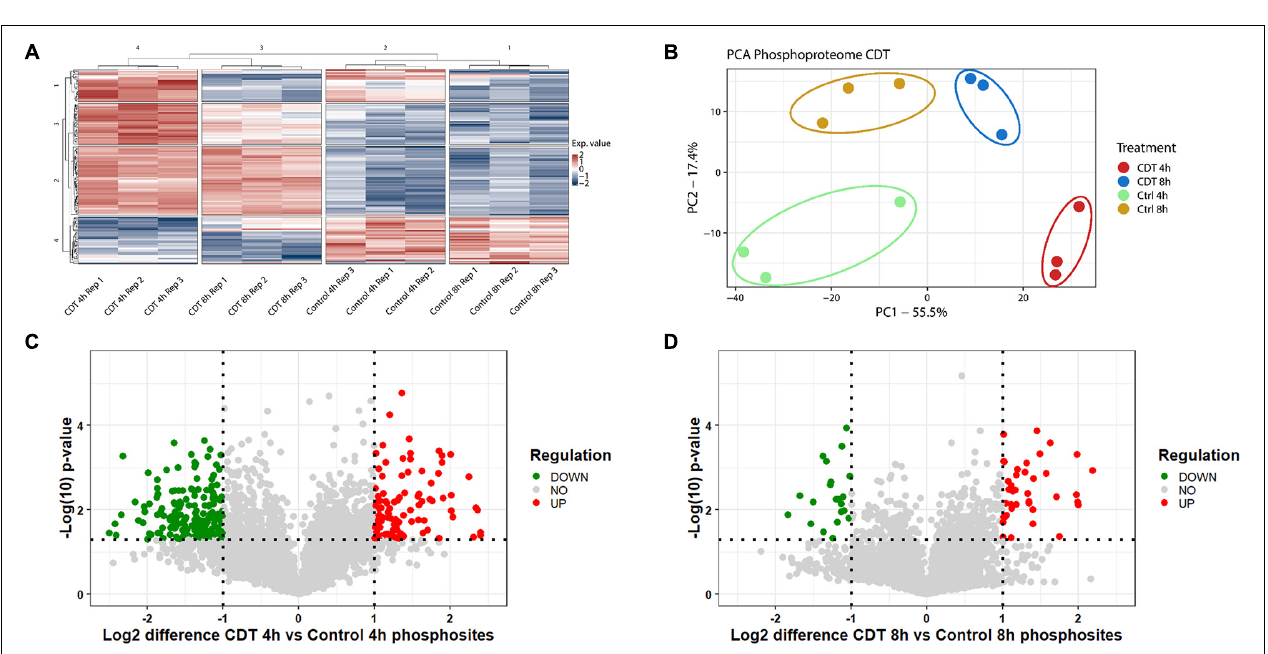
FIGURE 3 | Phosphoproteome analysis of with CDT-treated HEp-2 cells after 4 and 8 h. (A) Heat map of significantly changed phosphosites ( p < 0.05) based on intensity values and Benjamini Hochberg FDR ANOVA testing; Exp. value: expression value; numbers of row and column cluster are for coordinative reasons and have no underlying meaning. (B) Principal component analysis (PCA) of significantly changed phosphosites ( p < 0.05) after FDR-based ANOVA testing (PC1: principal component 1; PC2: principal component 2). Volcano plots proteins of with CDT-treated HEp-2 cells after 4 h (C) and 8 h (D) , respectively, [ (C,D) Horizontal dotted line indicates p -value threshold of p < 0.05, vertical line twofold difference, green dots: twofold significant downregulation, red dots: twofold significant upregulation].